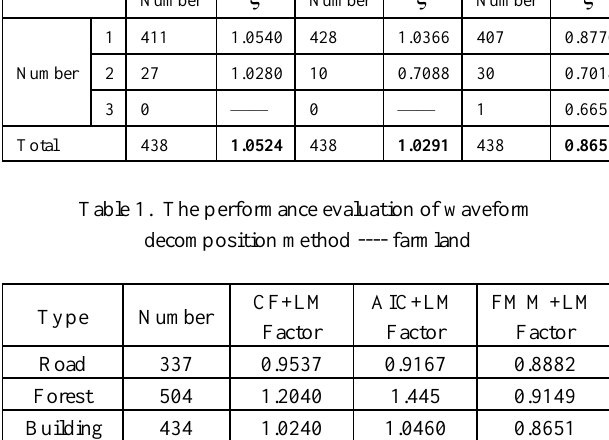
Table 2. The performance comparison of detection